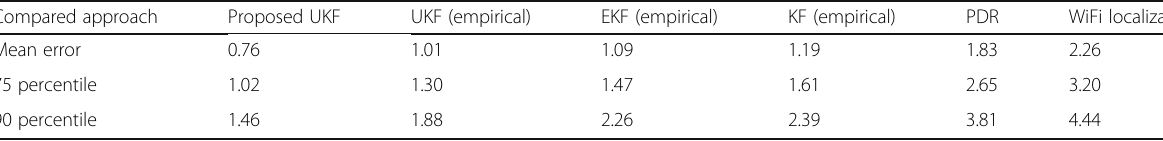
Table 2 Performance comparisons of various positioning error (m) measures Compared